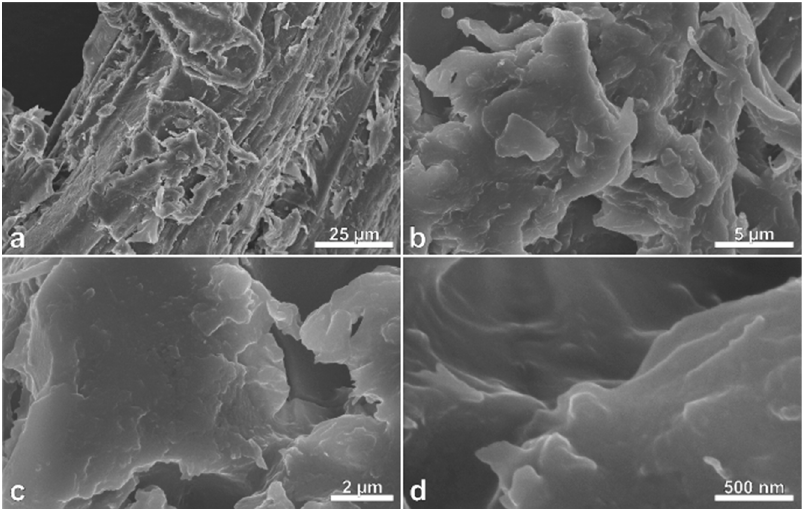
Figure 1. Field emission scanning electron photomicrographs (FESEM) of massaranduba ( Manilkara huberi ) sawdust showing particles surfaces ( a – d ), which consist mostly of highly lignified cell wall material.